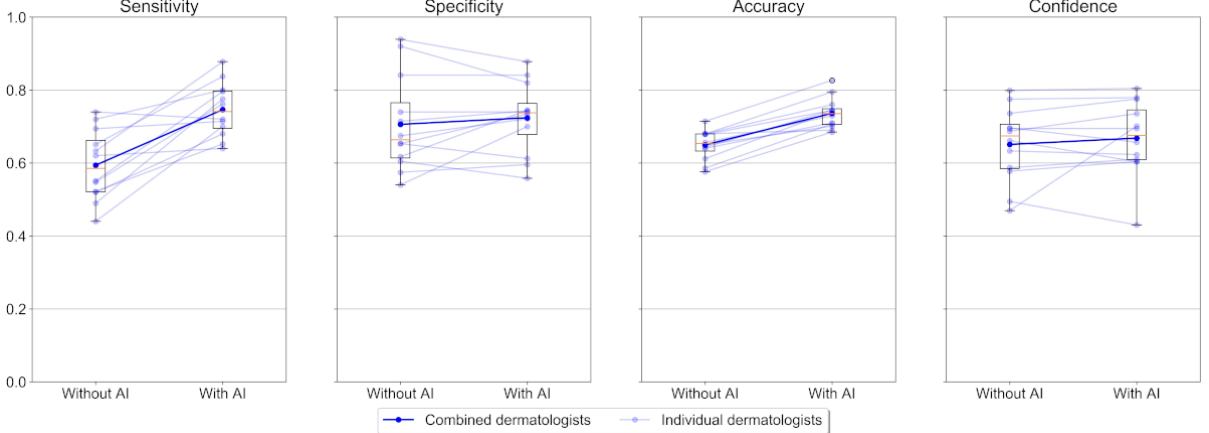
Figure 1. Combined and individual dermatologists’ performance without and with artificial intelligence (AI) support. Every dot represents a single participant. A line between 2 dots connects the participants' metric without AI support to the corresponding metric with AI support. Highlighted dots represent the participants combined. Boxes indicate 25th and 75th percentile while the horizontal line within shows the median (50th percentile). Whiskers indicate the data range (1.5*IQR) where points beyond are considered as outliers.